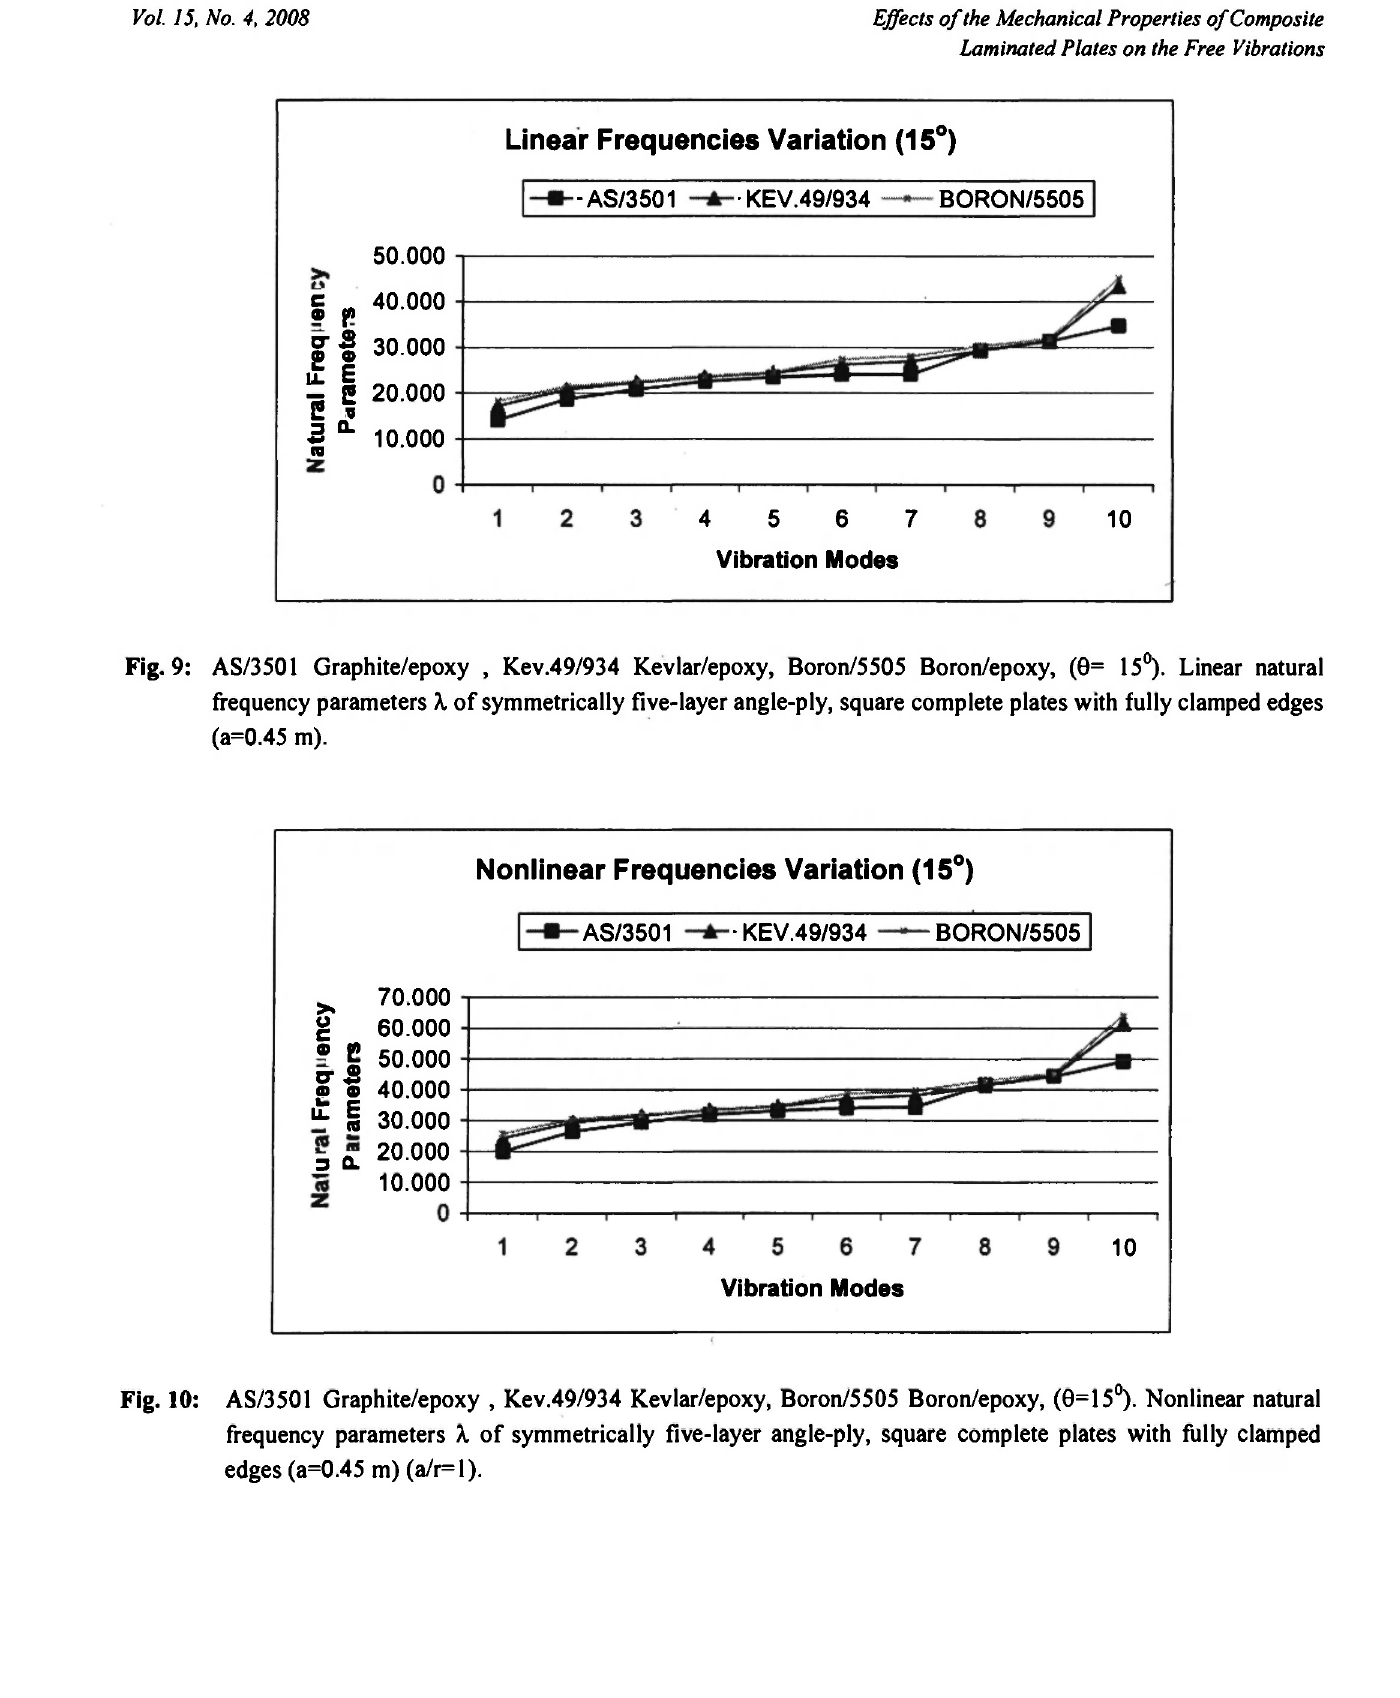
Fig. 10: AS/3501 Graphite/epoxy , Kev.49/934 Kevlar/epoxy, Boron/5505 Boron/epoxy, (0=15°). Nonlinear natural frequency parameters λ of symmetrically five-layer angle-ply, square complete plates with fully clamped edges (a=0.45 m)